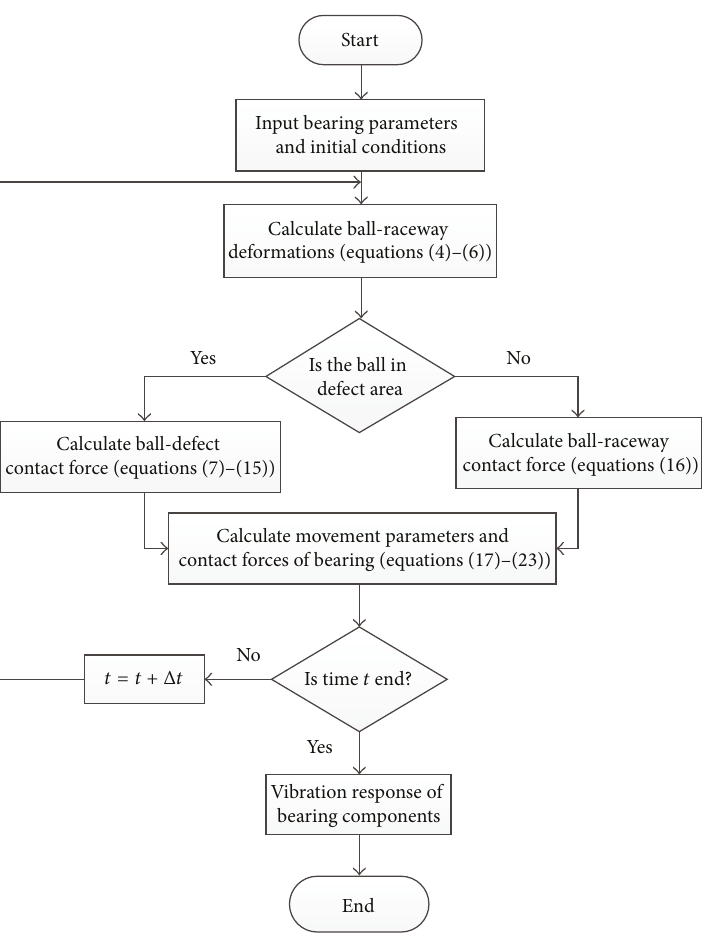
Figure 8: Flow chart of the numerical